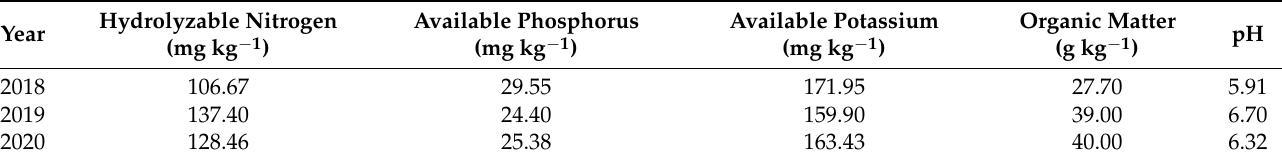
Figure 1. Temperature and rainfall during dry direct-seeded rice cultivation during 2018–2020. Table 1. Physiochemical properties of the soil at the experiment site between 2018 and